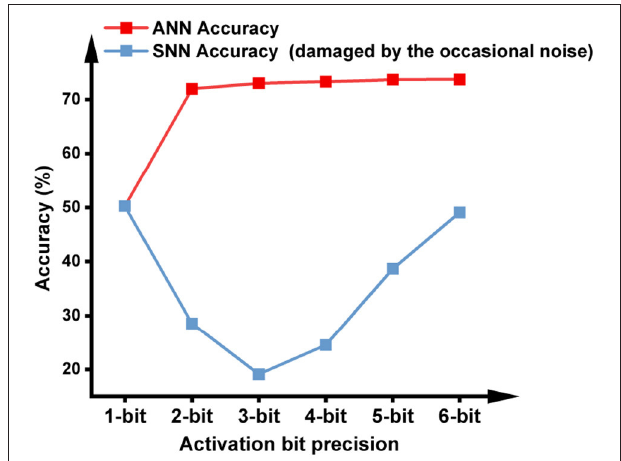
FIGURE 3 | ANN accuracy after quantization training with different bit precisions, and SNN accuracy without handling the occasional noise. The model is VGG-16 and the dataset is ImageNet. The ANN-to-SNN conversion is based on the approach proposed in this paper to facilitate the conversion of low-bit